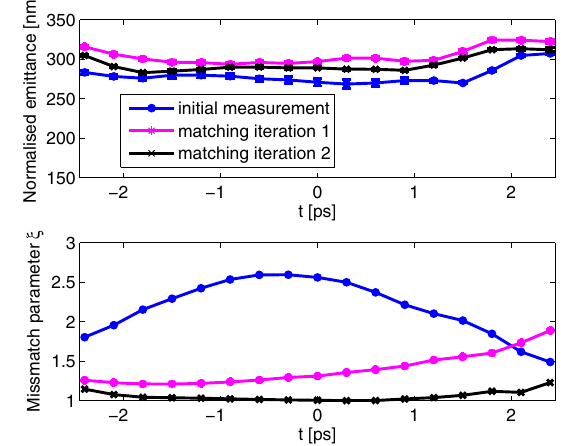
FIG. 5. An example of matching iterations of the longitudinal beam core. The emittance measurements (top) are compared with the mismatch parameter ξ along the bunch (bottom). The beam charge is 200